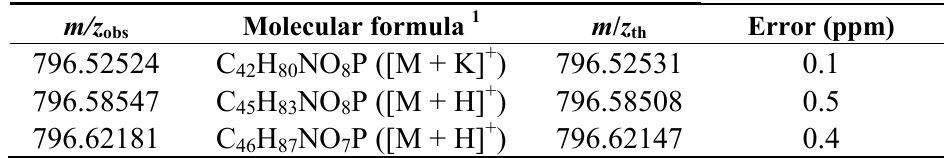
Table 4. Elemental formulas of minor PL species ( m/z 796.52524, 796.58547, and 796.62181) detected during MALDI MSI